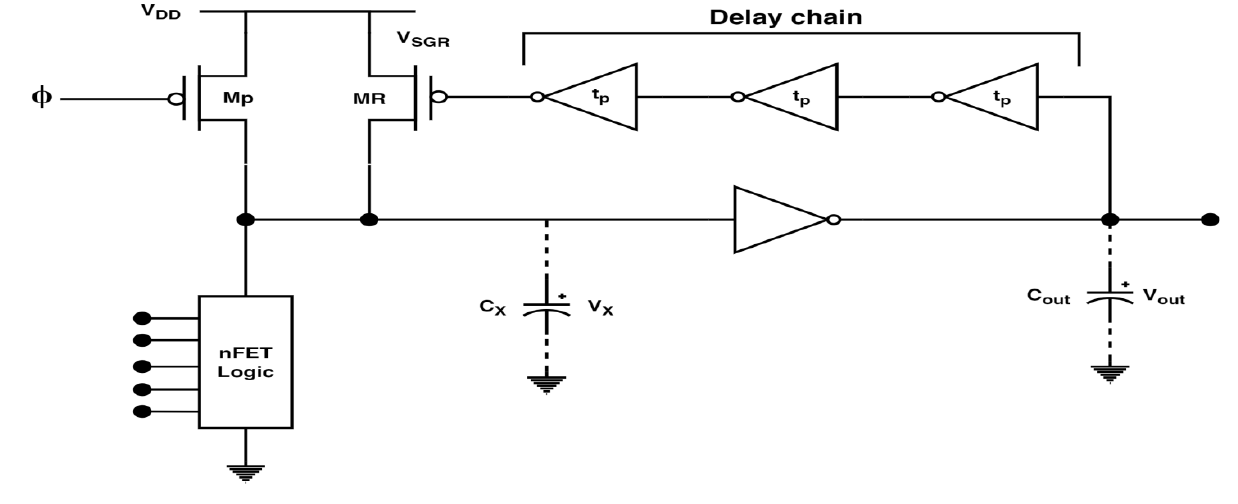
Figure 11. A self-resetting logic circuit (SRLC).